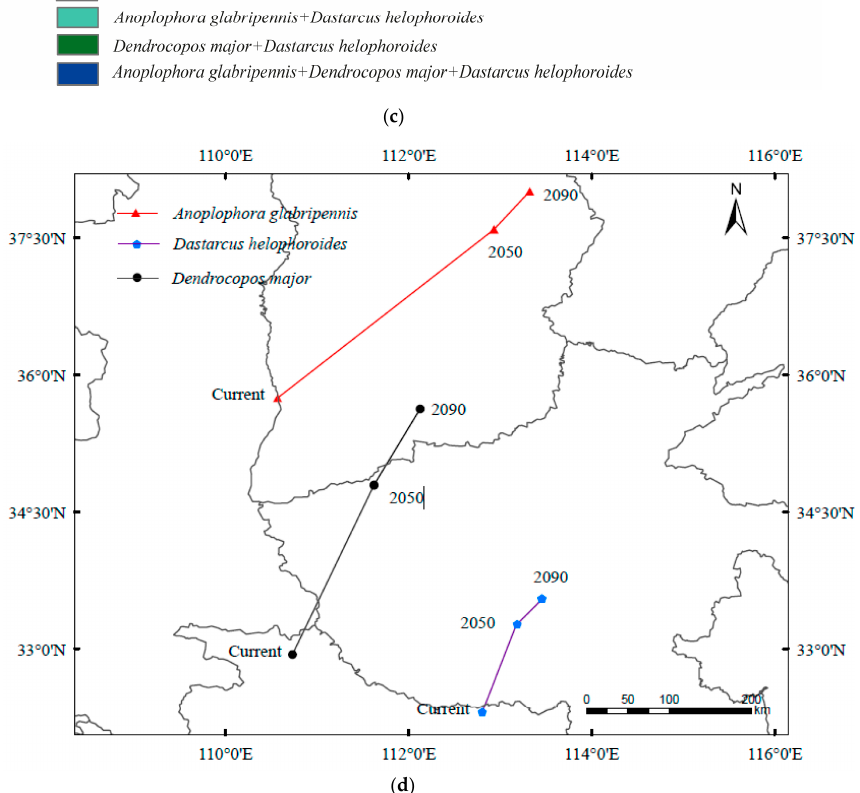
Figure 8. Prediction of overlapping suitable areas of Anoplophora glabripennis , Dastarcus helophoroides , and Dendrocopos major in ( a ) current, ( b ) 2050, and ( c ) 2090 stages and ( d ) centroid transfer trajectory in